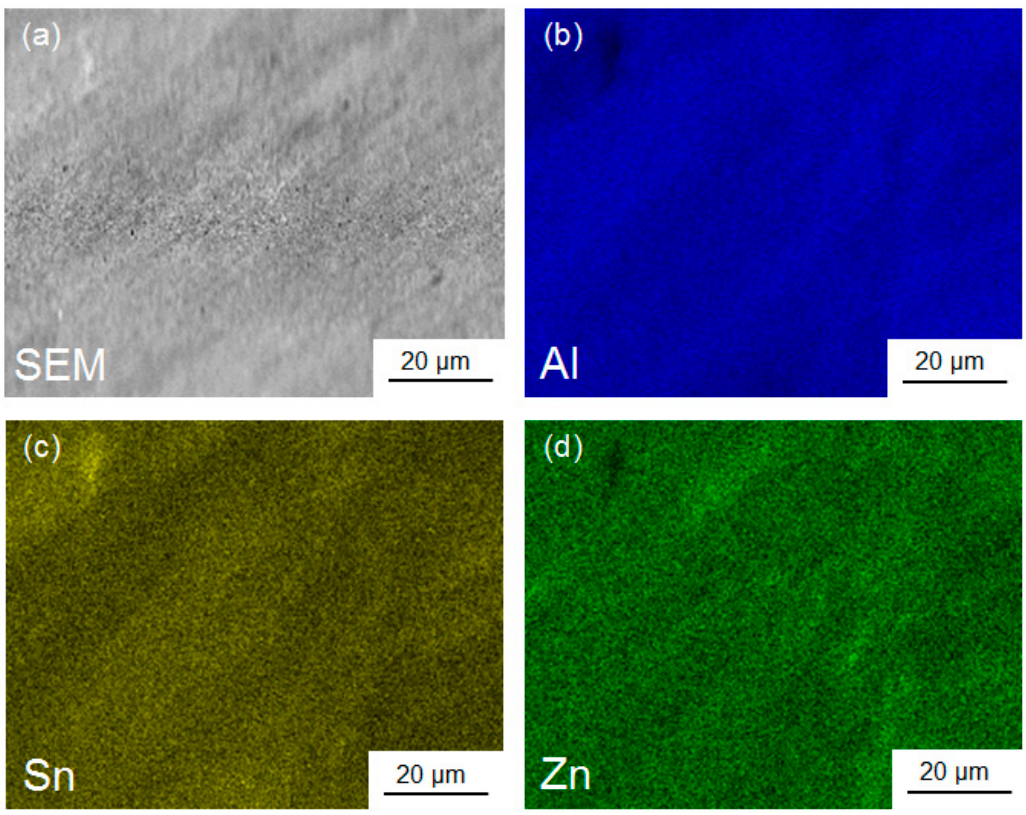
Figure 4. ( a ) SEM image and corresponding EDS mappings with ( b ) Al, ( c ) Sn, and ( d ) Zn for the Al-30wt %Sn-10wt %Zn ingot after processing by HPT for N = 5.